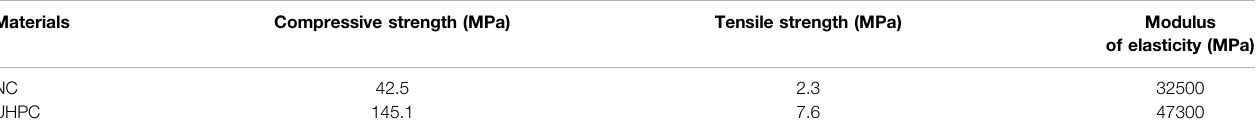
TABLE 2 | Mechanical properties of NC and UHPC.